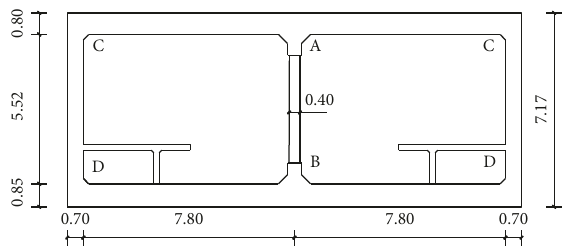
Figure 1: The cross section of the subway station structure (unit: m).